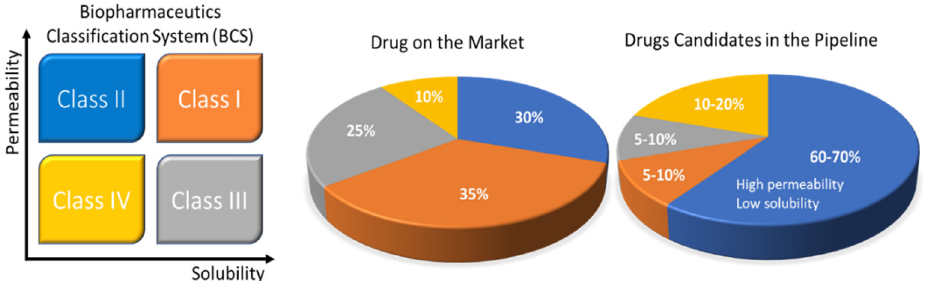
Figure 1. Solubility challenges that plague the oral drug-delivery frontier. The Biopharmaceutics Classification System (BCS) uses drug permeability and solubility as metrics for oral absorption. The four categories include BCS Class I (orange: high solubility, high permeability), Class II (blue: low solubility, high permeability), Class III (black: high solubility, low permeability), and Class IV (yellow: low solubility, low permeability). The pie charts to the right show the estimated distribu- tion of marketed and pipeline drugs by BCS classes. The pharmaceutical company data are also presented in the pie charts. Reprinted and adapted with permission from ref. [14]. Copyright 2018 Bioconjugate chemistry .